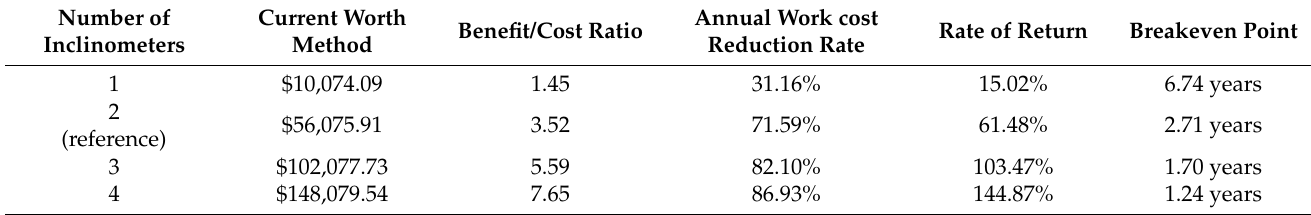
Table A1. Sensitivity analysis results according to the number of